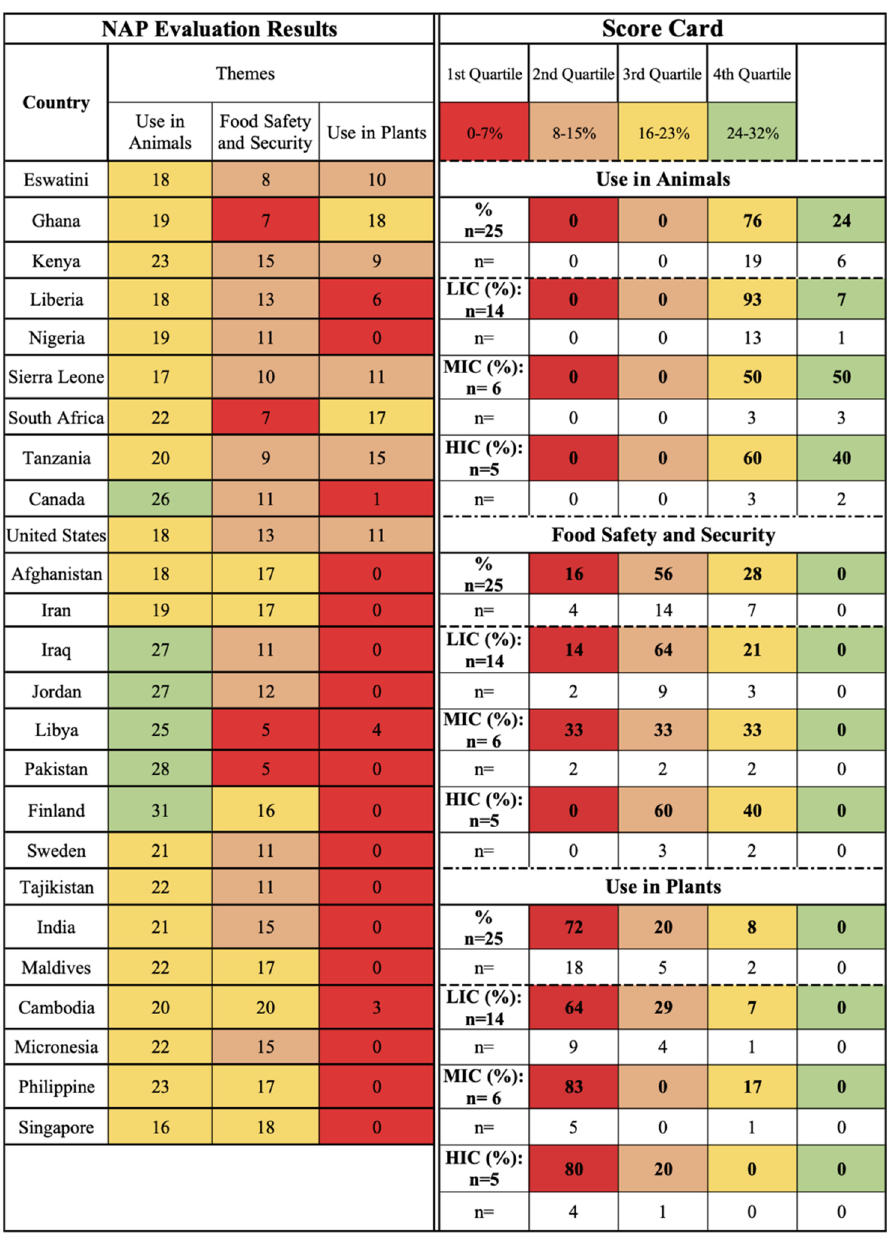
Figure 5. Animal sector themes (antimicrobial use in animals, food safety and security, antimicrobial use